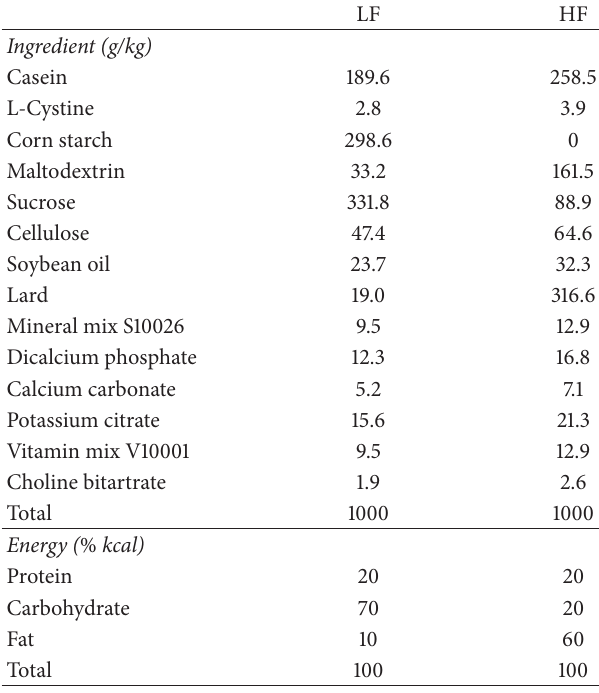
Table 1: The compositions of high fat and low fat diets used in this